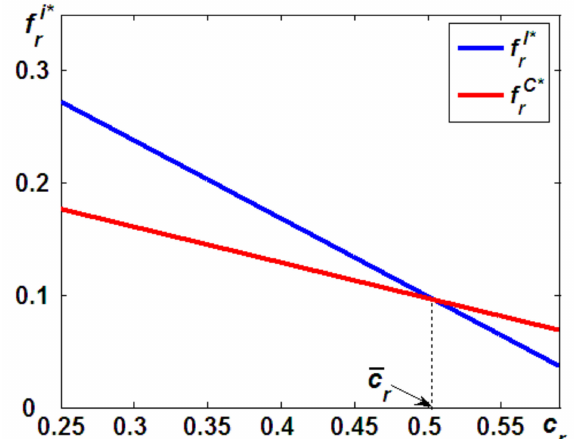
Figure 3. Differences in the relicensing